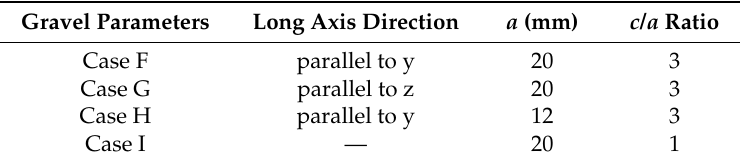
Figure 13. 3D numerical model and the four cases. ( a ) is the 3D model sketch. ( b ) is a quarter of the ellipsoidal gravel showing axial sizes. ( c – f ) are diagrams corresponding to Cases F, G, H and I, showing gravels in different sizes, axial ratios and distributions. The yellow dashed line shows the gravel’s long axis. The right endpoint of the blue dashed line overlaps the cube center. Table 4. Gravel size and distribution parameters in each